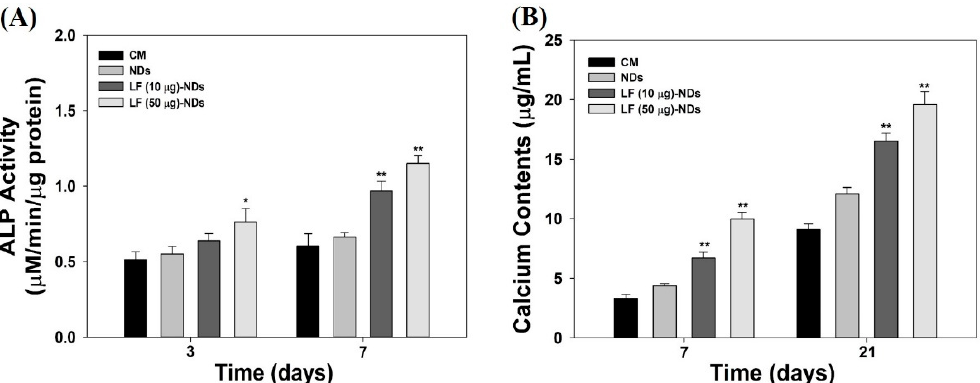
Figure 8. ( A ) Alkaline phosphatase (ALP) activity of MC3T3-E1 cells treated with LF (10 μ g)-NDs and LF (50 μ g)-NDs after 3 and 7 days of incubation; ( B ) Calcium deposition by ME3T3-E1 cells treated with NDs, LF (10 μ g)-NDs and LF (50 μ g)-NDs after 7 and 21 days of incubation. The error bars represent mean ± standard deviation ( n = 4). p value is a comparison between LF-conjugated NDs and NDs. * p < 0.05 and ** p < 0.01.